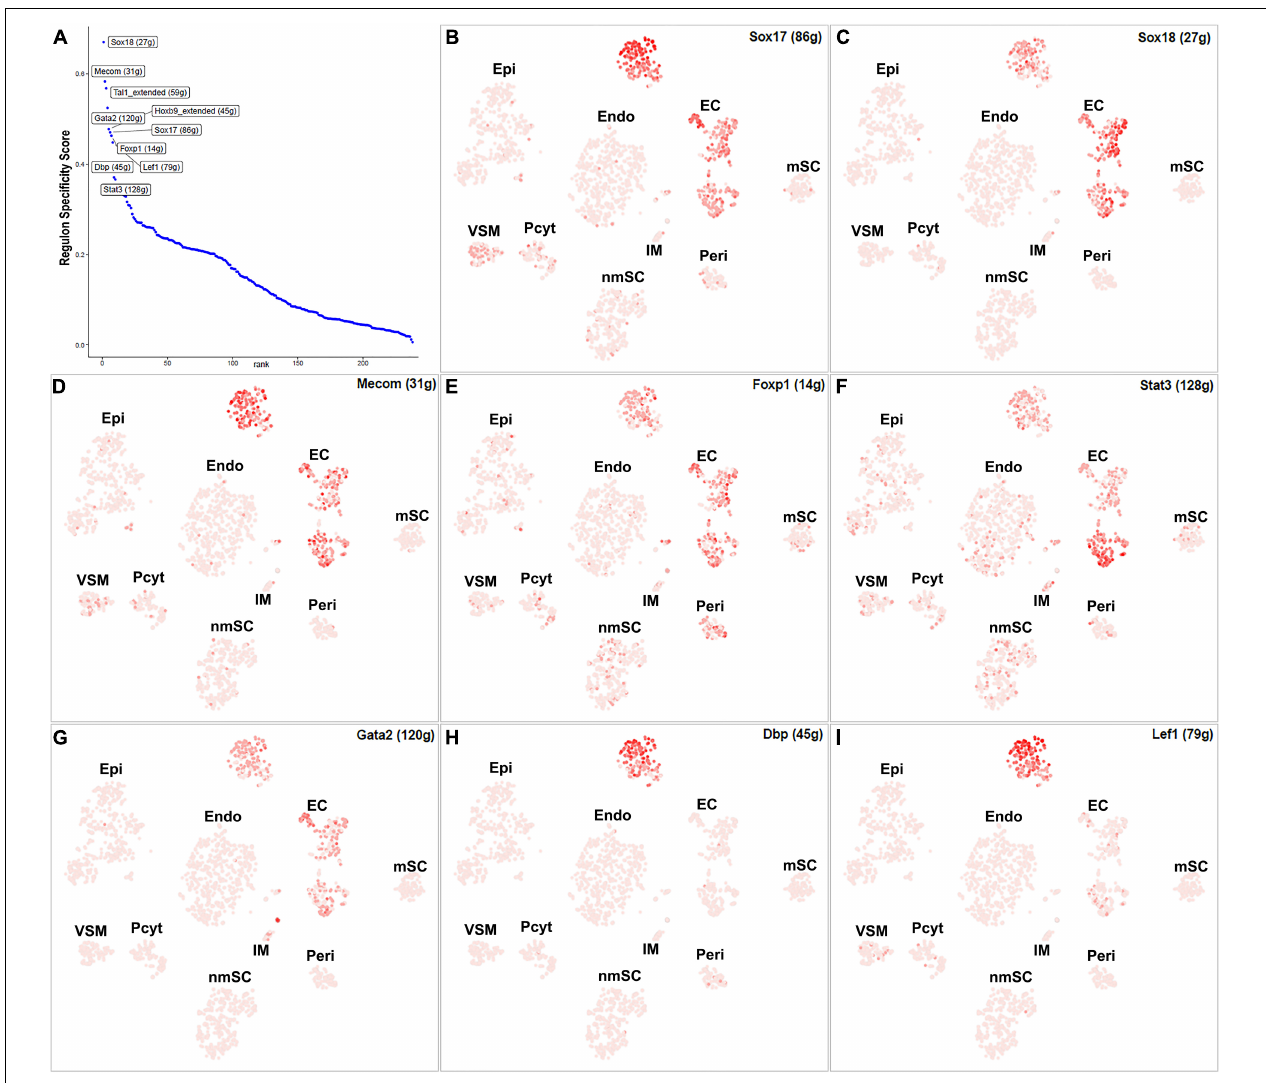
FIGURE 9 | TF activity in ECS. (A) Regulon-specificity score in ECs with top 10 specific TFs labeled. (B–I) The tSNE showing regulon activity for Sox17, Sox18, Mecom, Foxp1, Stat3, Gata2, Lef1, and Dbp in endothelial cells.